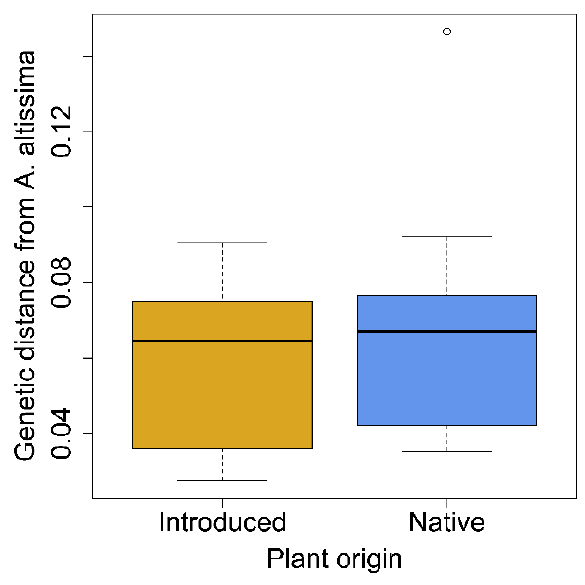
Figure 5. Genetic distances from Ailanthus altissima of native and introduced host plants of Lycorma delicatula based on the sequence data for the rbc L gene (ribulose-1,5-biphosphate carboxylase-oxygenase) retrieved from the NCBI GenBank Database. Boxplots represent the median (thick horizontal line), the 25th and 75th percentiles (the box), the 5th and 95th percentiles (the whiskers). No significant differences between native and introduced host plants were detected at α = 0.05.